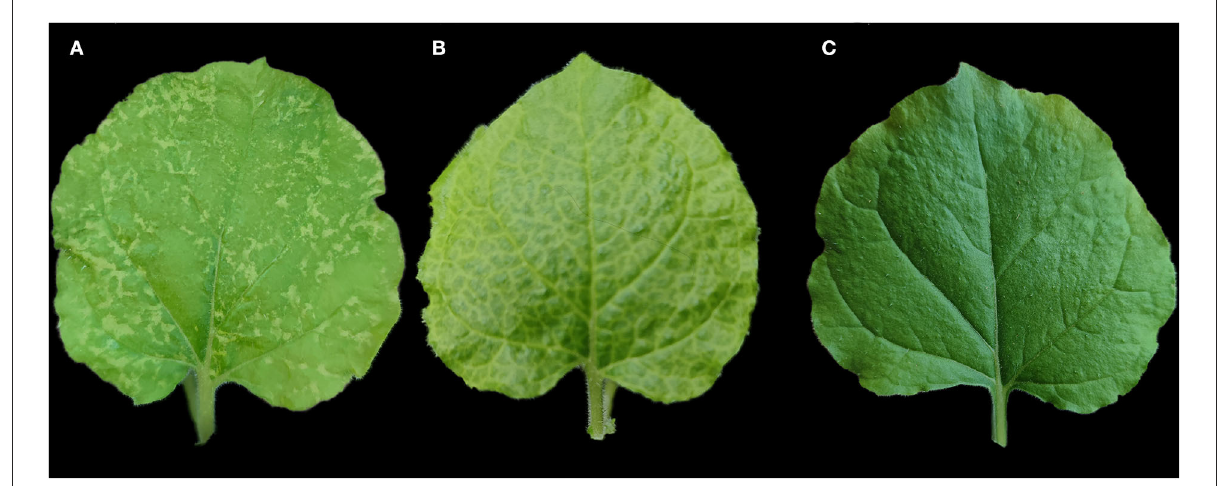
FIGURE4 Mechanical inoculation of Pueraria lobata -associated emaravirus (PloAEV) to Nicotiana benthamiana . (A) The systemic leaf of N. benthamiana inoculated with sap from symptomatic Pueraria lobata leaves infected by the three viruses showed chlorotic spots. Treatment with sap from (B) leaves infected by potato virus X (PVX) and (C) inoculation buffer as the positive or negative